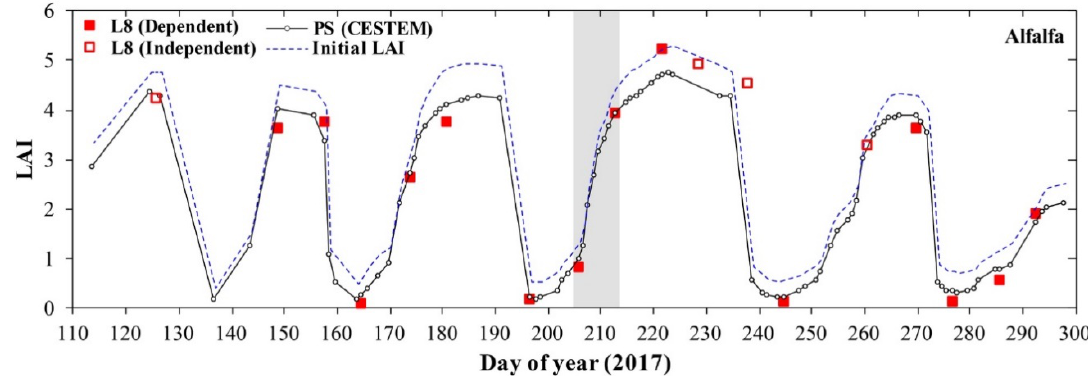
Figure 6. CESTEM-based time series of PlanetScope (PS) LAI for the alfalfa study-unit (Figure 1) using eight-day Landsat 8 (L8) reference data (i.e., dependent scenes). Retrievals from the four L8 scenes not included in CESTEM (i.e., independent scenes) are also shown. The dashed line depicts the initial LAI series used to quantify the change in LAI over given CubeSat–Landsat acquisition timespans as part of the reference sampling scheme (Section 2.4.4). The shaded area indicates the vegetative period used for illustrative purposes in Figure 7.